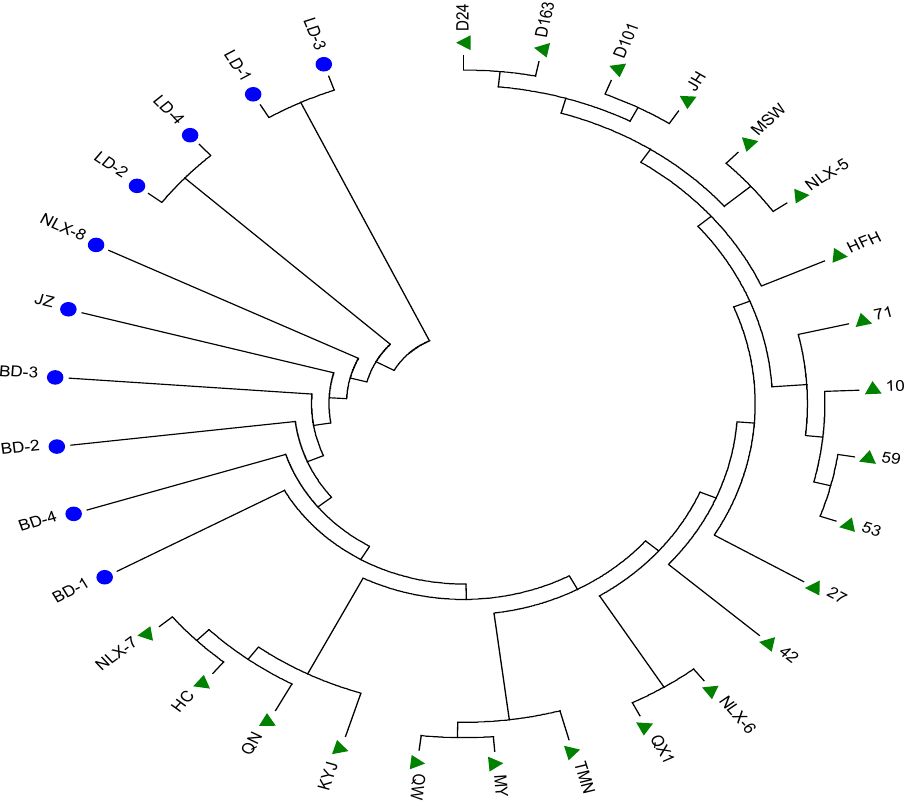
Figure 2. Neighbor-joining (NJ) phylogenetic tree showing the evolutionary relationships among the 32 genotypes of durian in durian plantations in Hainan. The branch node with blue (round shaped) and green (triangle) represent Group 1 and 2, respectively.